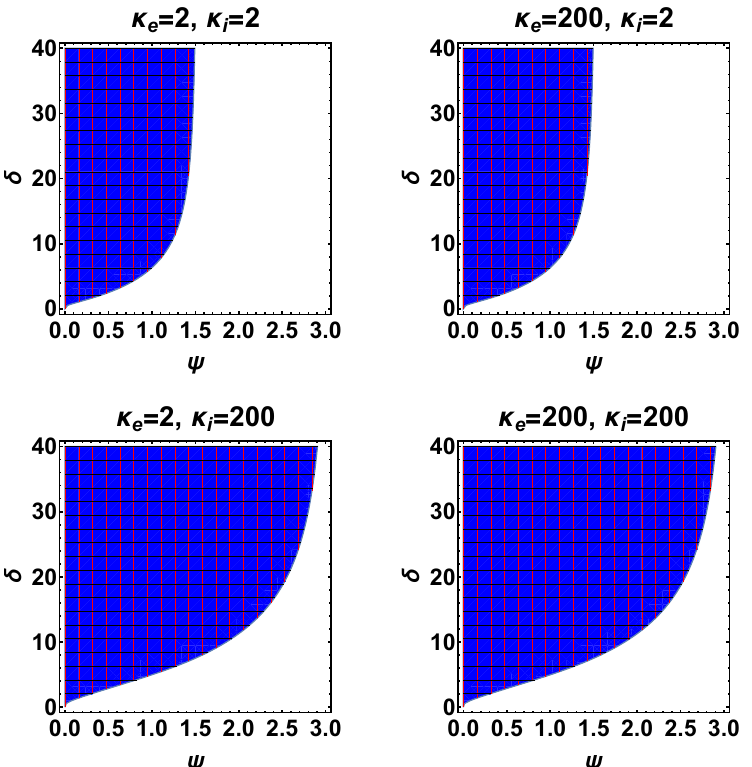
Figure 1. The width-amplitude relation for different configuration of ion and electron distribution function is shown for temperature ratio, T r = 0.5. The blue-shaded regions correspond to the parameter space that permits the existence of ion